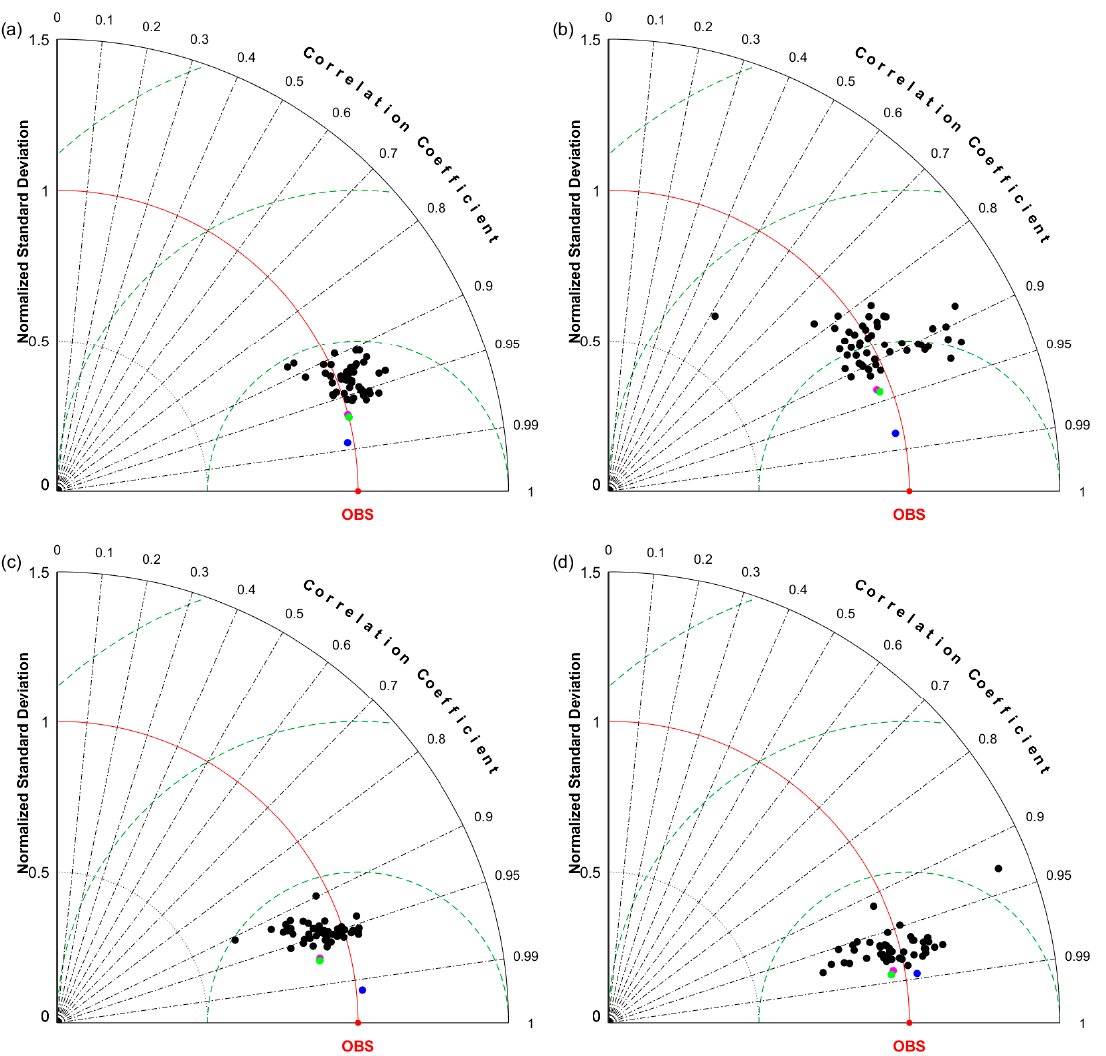
Figure 13. Taylor diagram of the estimations from the SMA method, the BMA method, the CERES EBAF, and the 48 GCMs over high-latitude areas from 2000 to 2005 in the Southern Hemisphere. The SMA method, the BMA method, the CERES EBAF, and the 48 GCMs are represented by purple, green, blue, and black dots, respectively. ( a ) Spring, ( b ) summer, ( c ) fall, ( d ) winter.